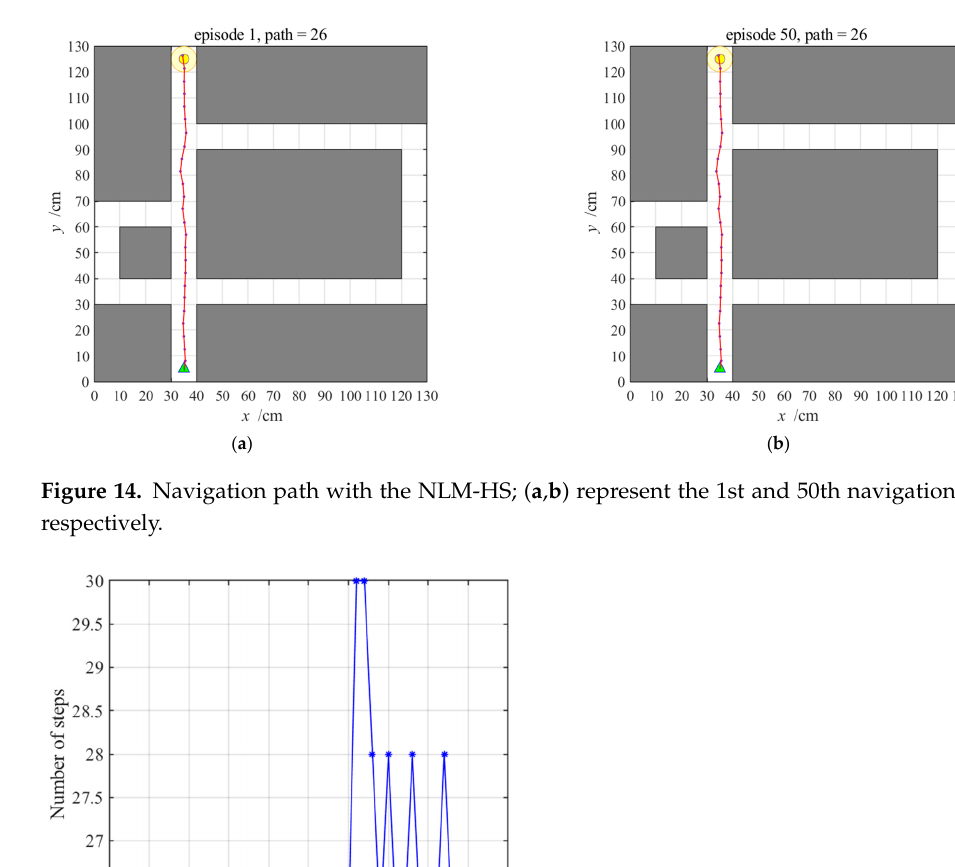
Figure 14. Navigation path with the NLM-HS; ( a , b ) represent the 1st and 50th navigation paths, respectively.